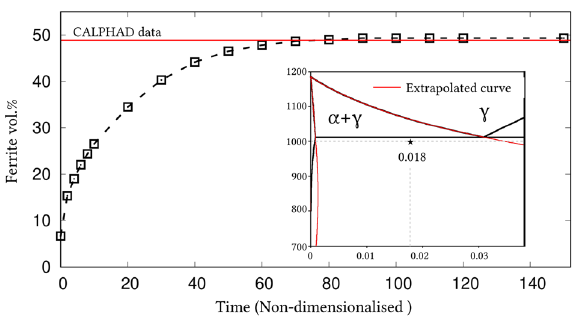
Figure 4. Progressive increase in the volume-fraction of ferrite, with time, which accompanies the austenite decomposition modelled through the present approach. Phase-fraction predicted by CALPHAD is included to verify the quantitative aspect of the treatment. As a subset, phase-diagram with extrapolated curves determined from TcFe8 data is